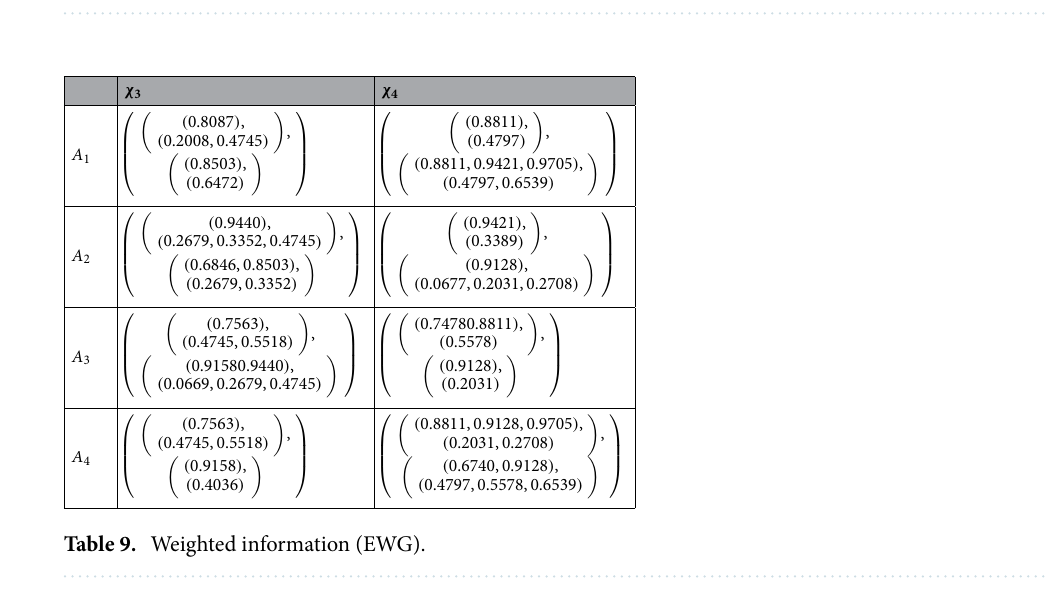
Table 8. Weighted information (EWG).